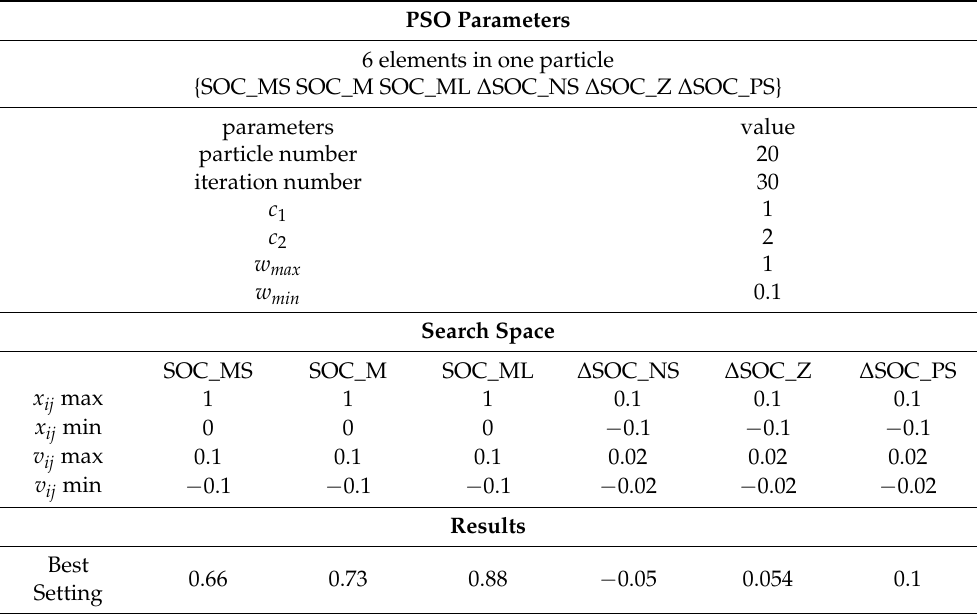
Table 3. Particle swarm optimization (PSO) configurations.